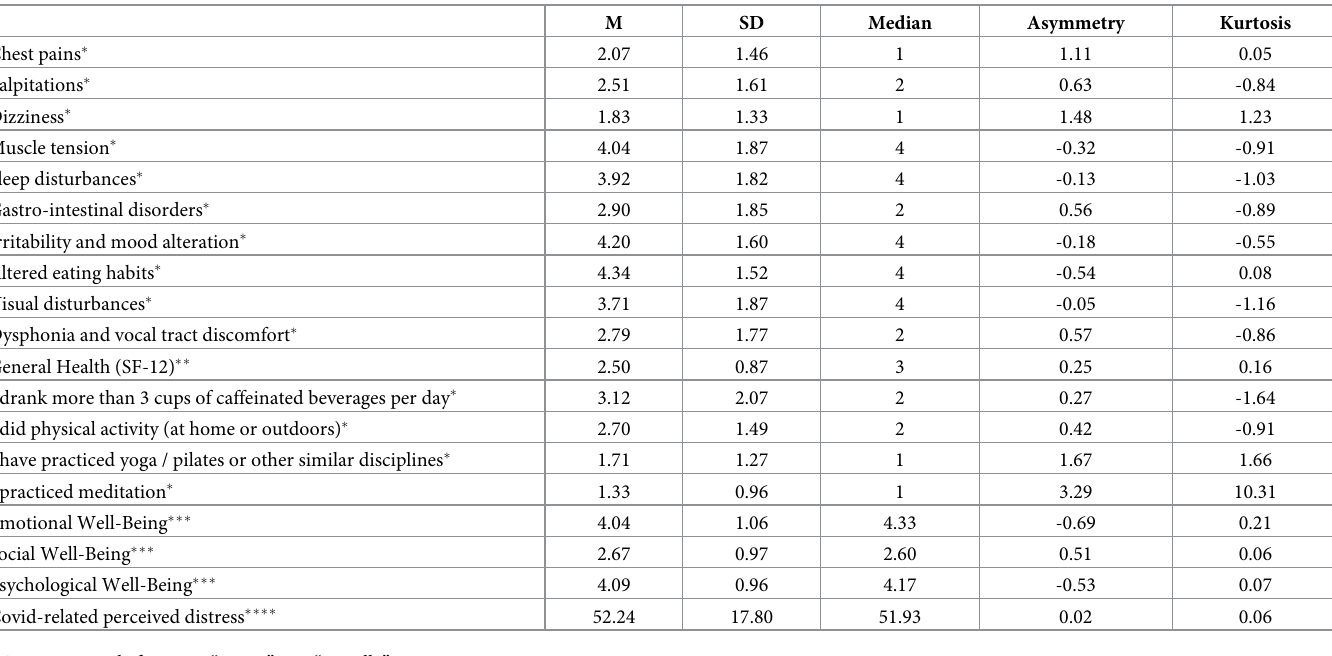
Table 8. Descriptive statistics for physical and psychological correlates on total sample (N =